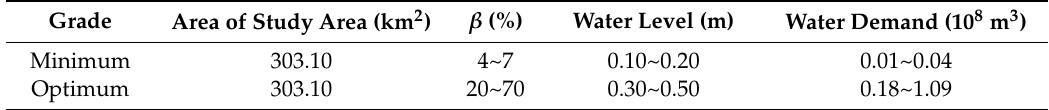
Table 4. Water demand for stopover